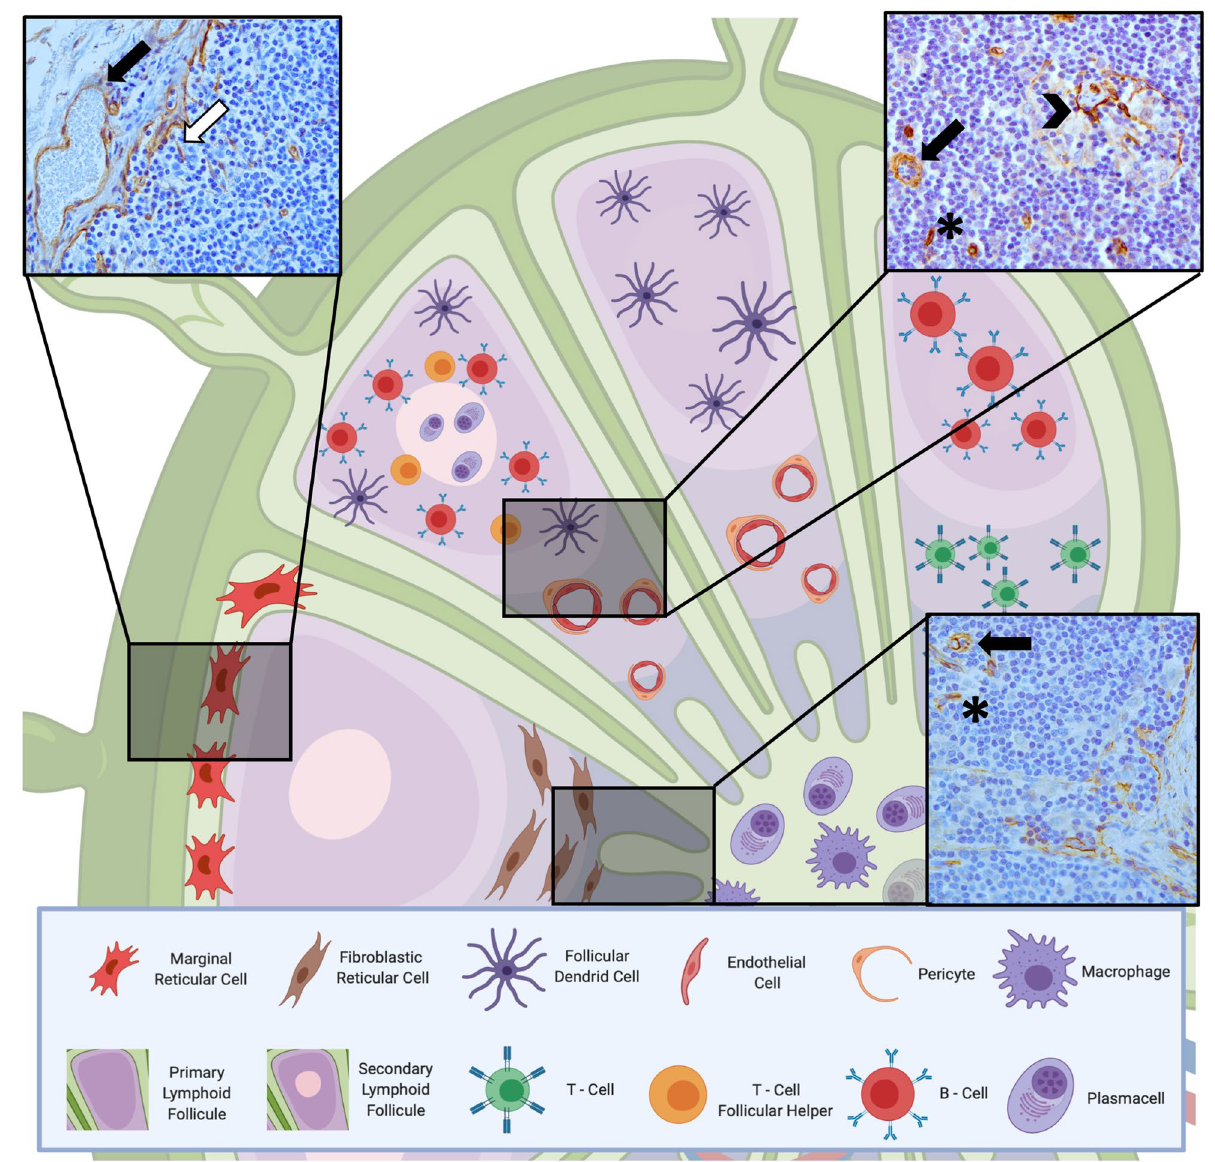
Figure 1. Illustration of fibroblast-like stromal cells in a lymph node. In the insets three examples of sCav-1 positive cells in a normal lymph node. Together with endothelial cells (black arrow) and pericytes, fibroblast-like stromal cells, such as marginal reticular cells (white arrow) under the subcapsular sinus, fibroblastic reticular cells in the paracortex/T cell zone (*), and follicular dendritic cells in lymphoid follicles (arrowhead) constitute the stromal compartment of a lymph node. All IHC images magnification: 200x. Created with